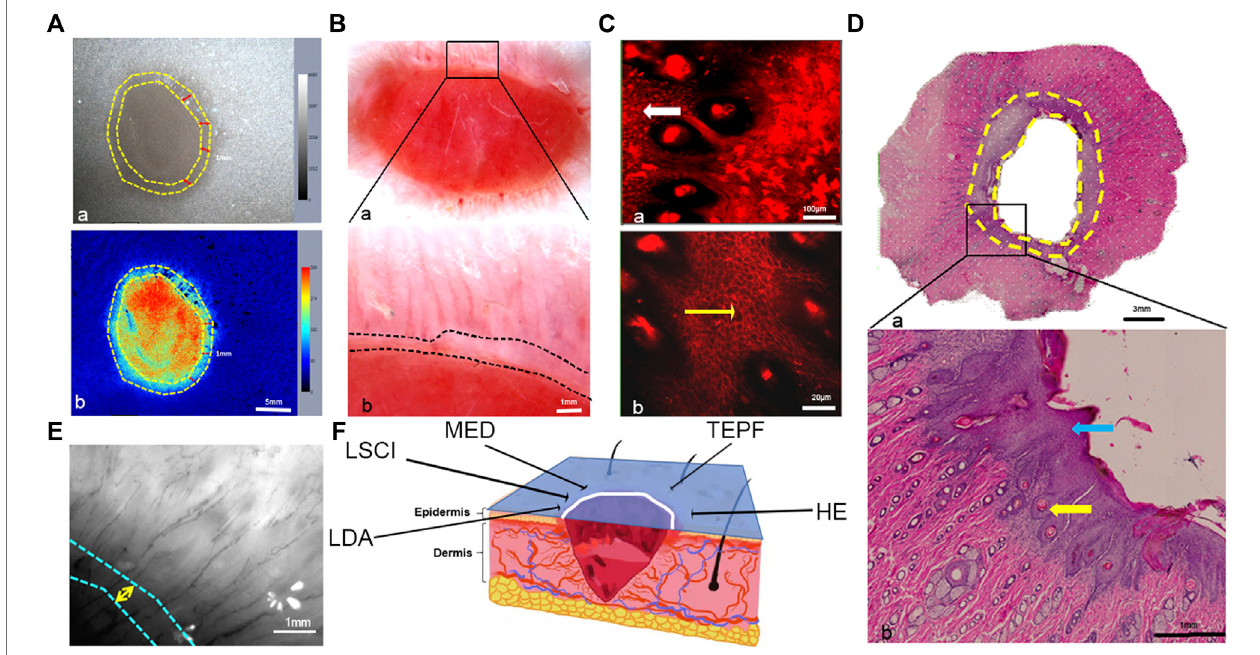
FIGURE6| Observation ofthe horizontal plane on thewound margins. (A) Blood perfusion tracking withLSCI (the region between thetwoyellowdotted lines was the migrating epidermal cells). (B) Wound image with MED and enlarged view of the area marked with a black rectangle (the region between the white dotted lines indicated the migrating epidermal cells). (C) Wound margin imaging with TEPF (the region marked with a white arrow was enlarged, and the yellow arrow indicated the hairfollicle). (D) PanoramaofthewoundwithHEstaining(theareabetweenthetwoyellowdottedlinesindicatedthemigratingepidermalcells)andenlargedviewof the area marked with a black rectangle (the blue arrow marked the migrated epidermal cells, and the yellow arrow marked the new hair follicle surrounded by the epidermal cells). (E) Wound imaging with LDA (the region between the white and blue dotted lines indicated the migrating epidermal cells). (F) Schematic diagram of the woundanddifferentopticalmethods(thebluesectionistheobservationarea,thewhitelineistheobservationarea,andtheblackarrow-pointeddirectioncorrespondsto the various observation methods and results,